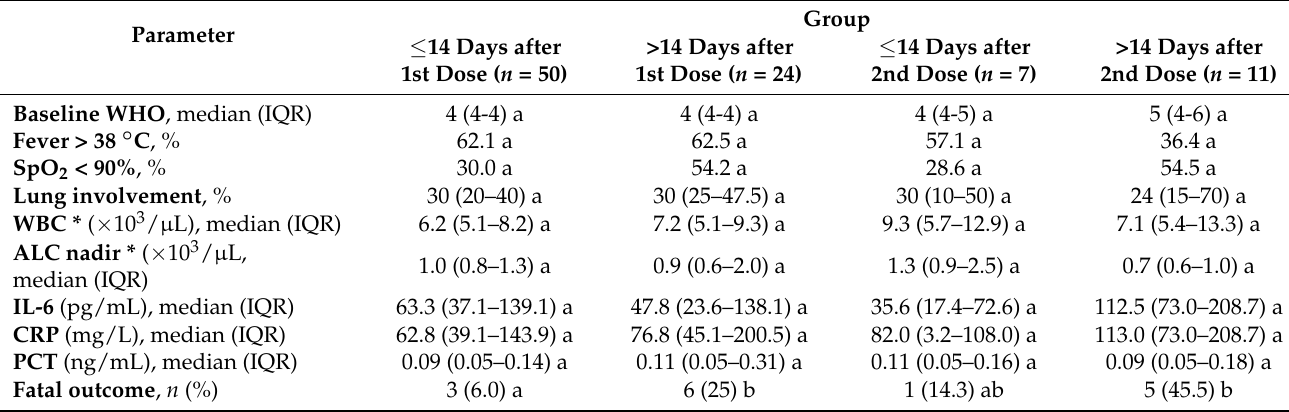
Table 2. The clinical characteristics of COVID-19 patients who previously received at least one dose of COVID-19 vaccine ( n = 92). Different letters in each row indicate statistically significant differences between the sub-groups ( p < 0.05) demonstrated with the post hoc Dunn’s test following the Kruskal–Wallis ANOVA or with the Pearson’s χ 2 test.